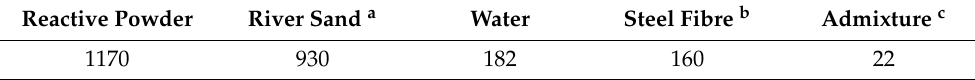
Table 1. Mixture proportions of the UHPC used (kg/m 3 ).